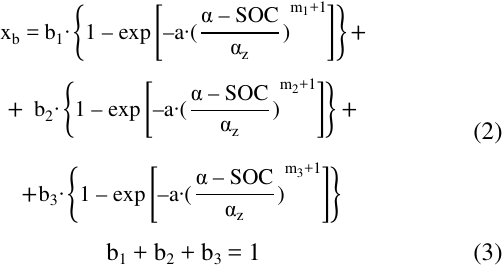
Table 1. Specifications of Cummins B6-T590 engine [8, 9] Parameter Data Type